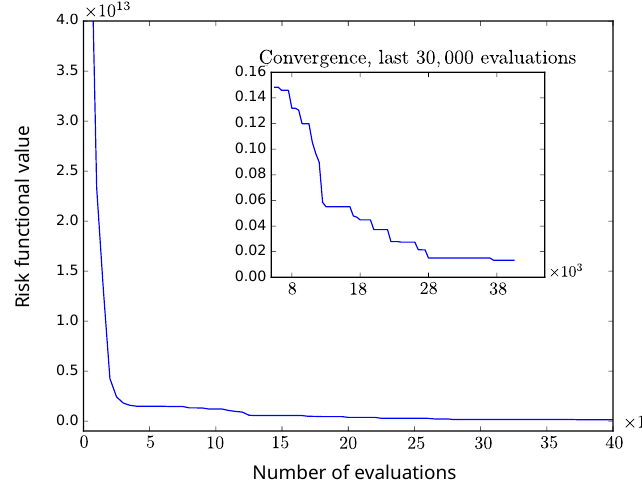
Figure 3. Convergence of the SA algorithm for Example 2.